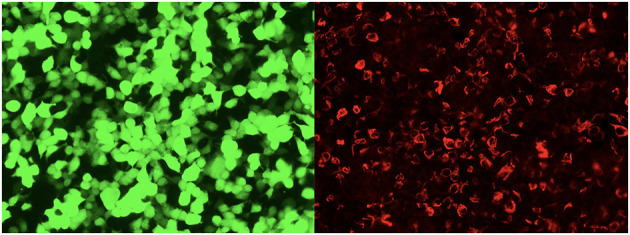
The glial fibrillary acidic protein autoantibodies in the cerebrospinal fluid of the patients were transfected into cell-indirect immunofluorescence detection: human embryonic kidney 293T (HEK293T), after cell fixation and permeabilization, immunofluorescence detection of GFAP autoantibodies in the sample. In the picture, green is the cells transfected to express GFAP, and red is human IgG that binds to the corresponding antigen.